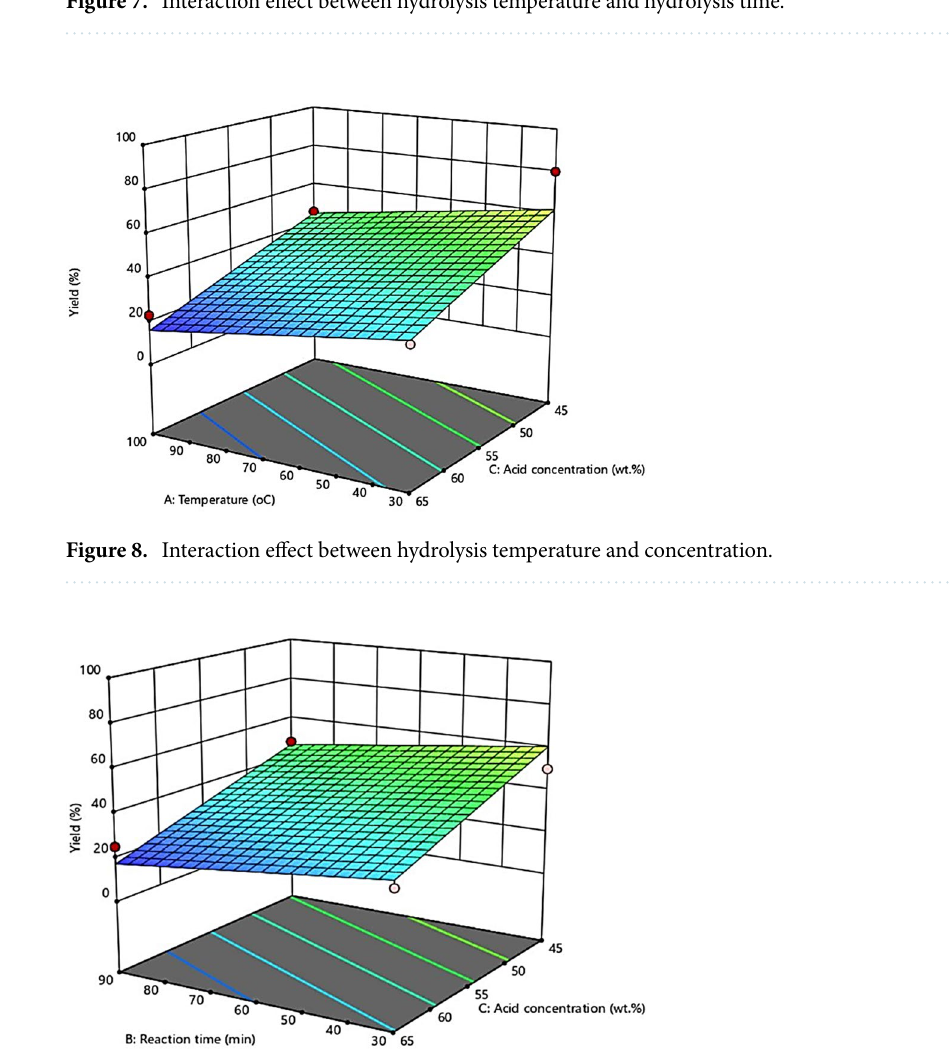
Figure 7. Interaction effect between hydrolysis temperature and hydrolysis time.